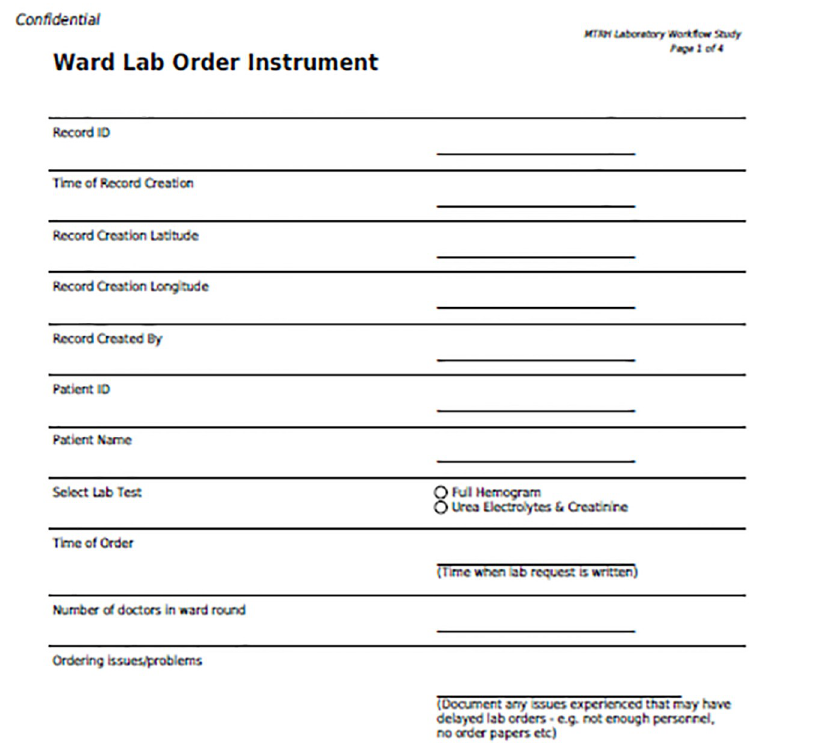
Fig 7. Ward to laboratory order instrument. Instrument used to record initial laboratory order.